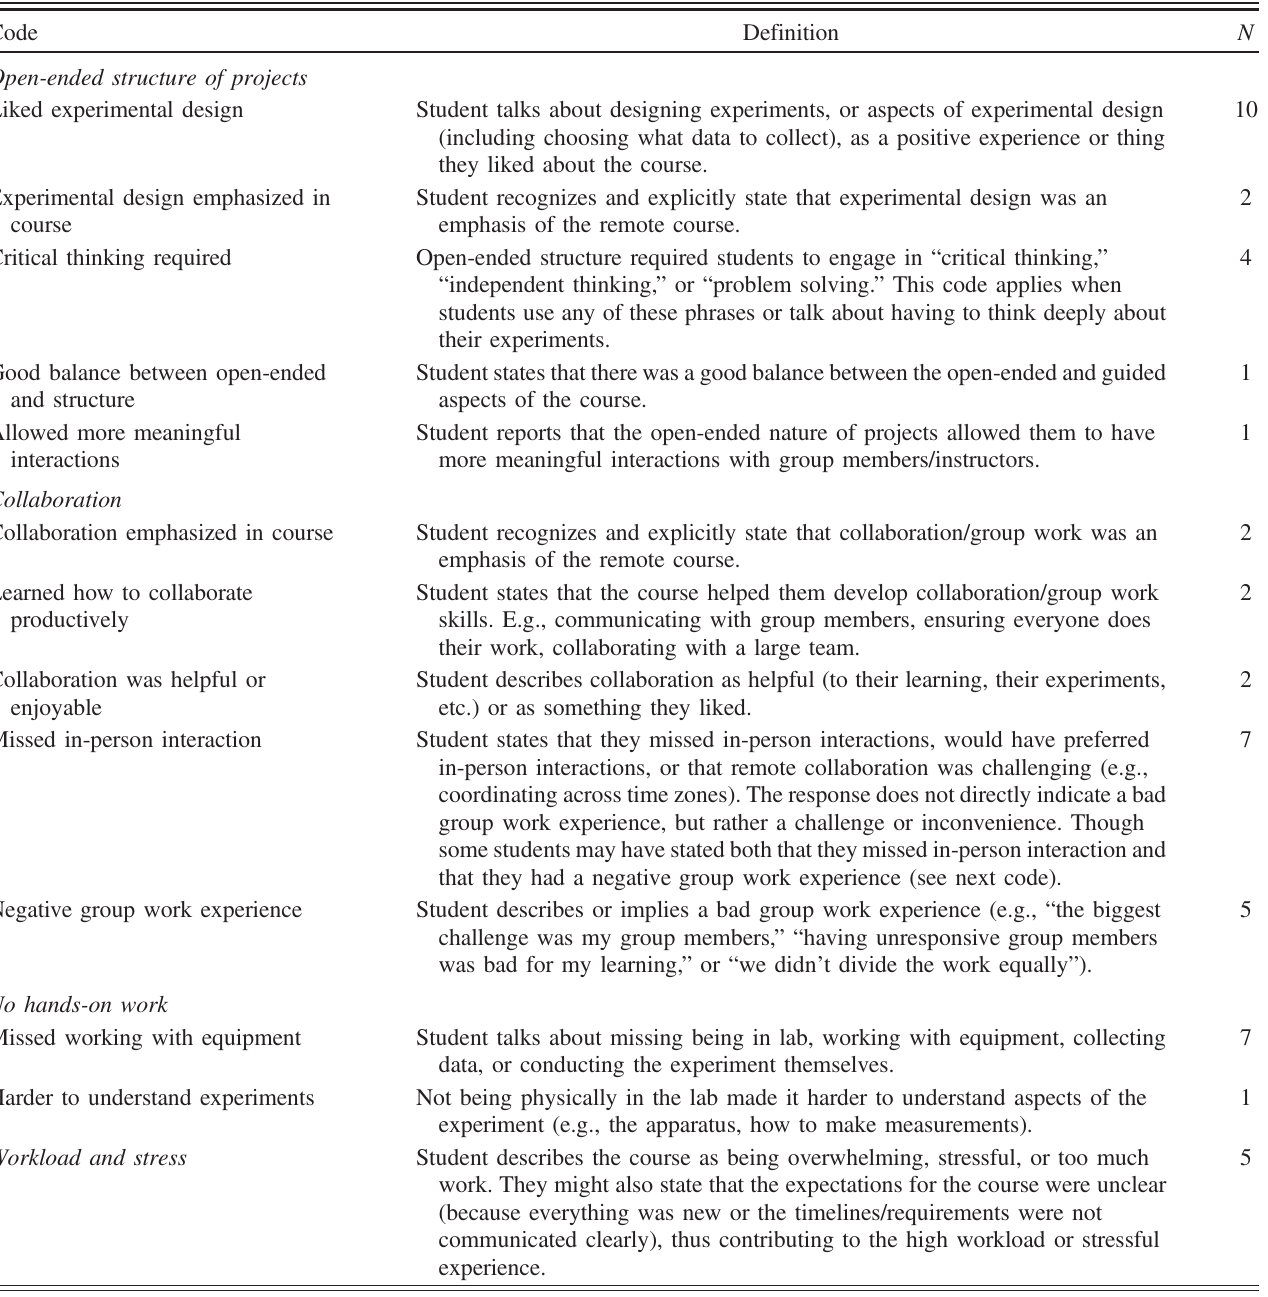
TABLE II. Emergent codes from the analysis of students ’ responses to open-response survey questions about the remote lab course. The 13 codes are categorized into four main themes: open-ended structure of projects, collaboration, no hands-on work, and workload and stress. N is the number of students who had at least one response coded with a given code (out of 16 students who answered some or all of the open-response